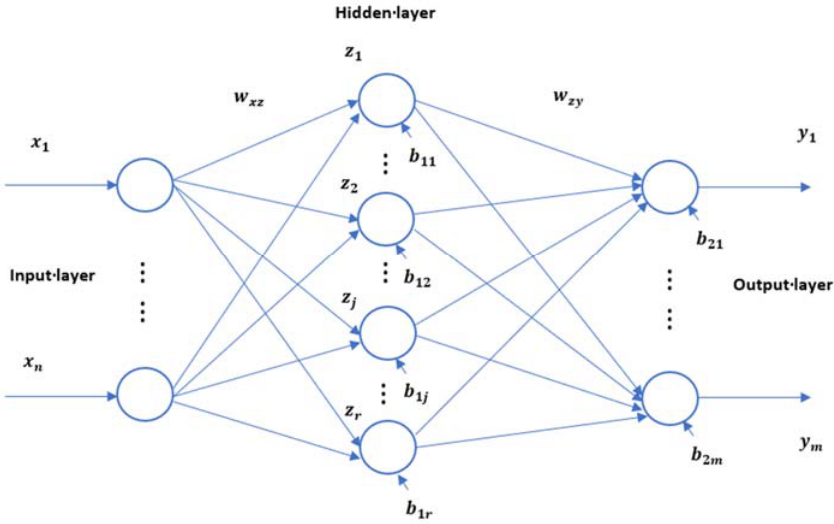
Figure 3. Structure of a 3 ‐ layer BP neural network.